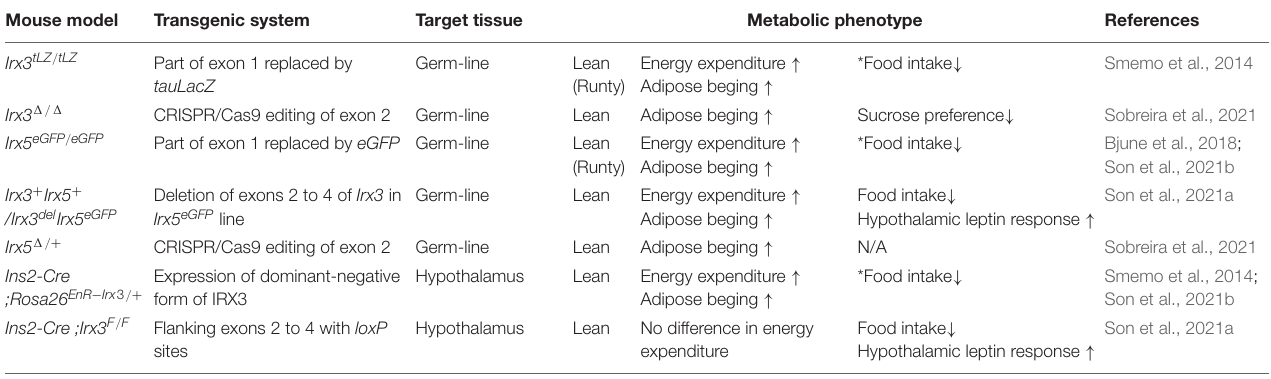
TABLE 1 | Summary of metabolic studies with Irx3 or Irx5 mutant